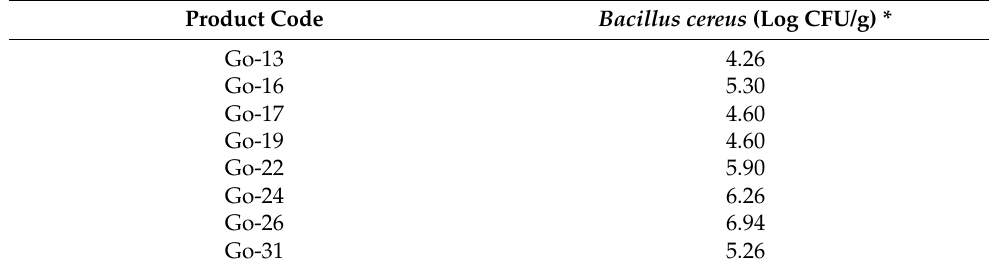
Table 3. Bacillus cereus count in gochujang